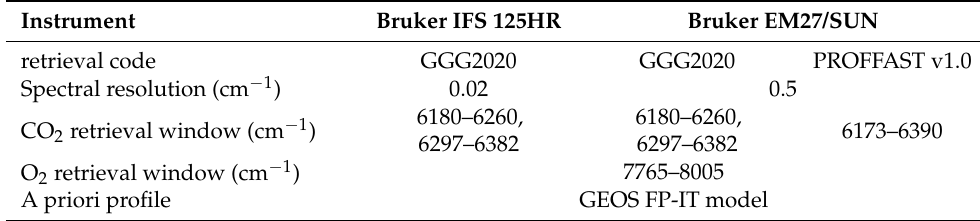
Table 1. The instrumental characters of Bruker IFS 125HR in Xianghe and Bruker EM27/SUN in Beijing, together with their XCO 2 retrieval